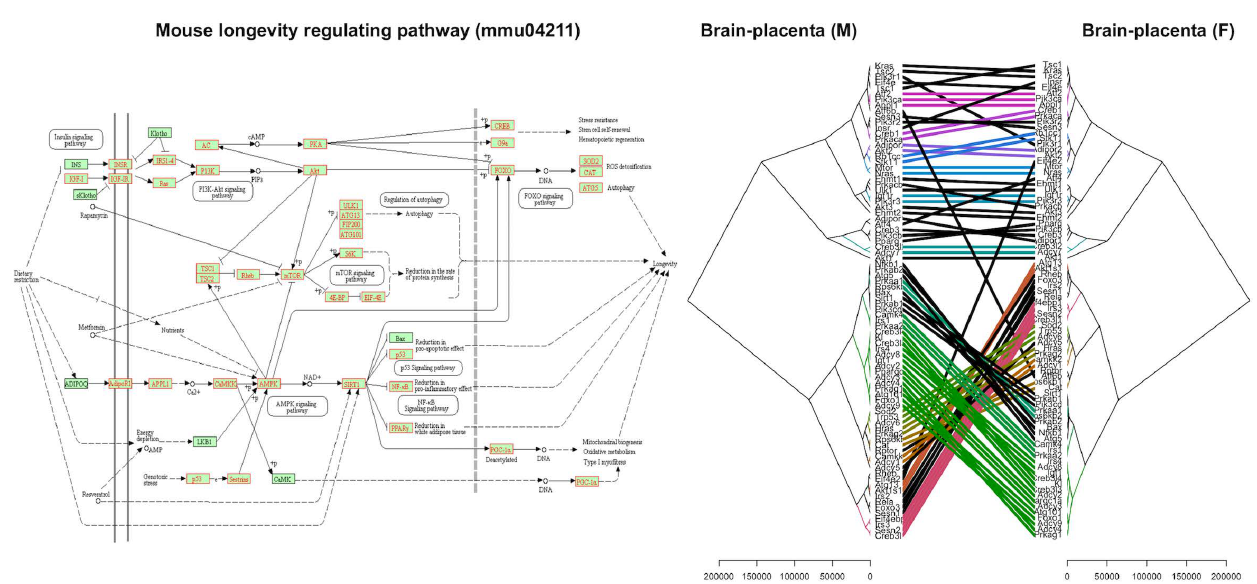
Figure 5. ( Left ): The mouse longevity regulation pathway (Kyoto Encyclopedia of Genes and Genomes, KEGG, pathway# mmu04211) genes expressed in the fetal brain and placenta are shown in red. ( Right ): A tanglegram plot shows the Int. J. Mol. Sci. 2021 , 22 , x FOR PEER REVIEW 7 of 12 expression pattern of the longevity regulation pathway genes in the placenta and fetal brain of males vs. females (sample size: n = 24). The scales below the plots show the measure of branch heights of the respective cladograms.